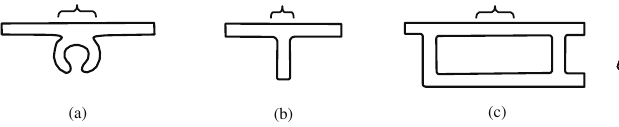
Figure 5. Examples of die streaks and typical areas where they might occur.